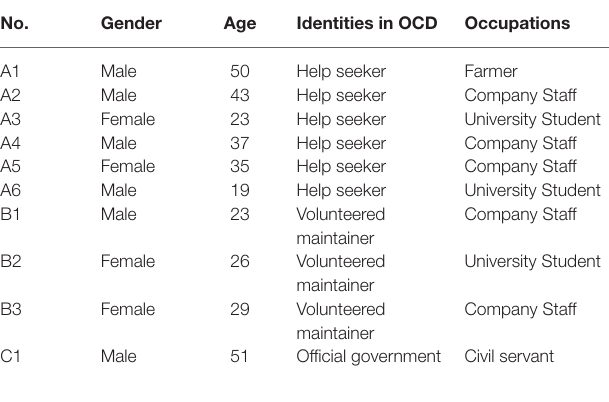
TABLE 1 | Demographic information for focus